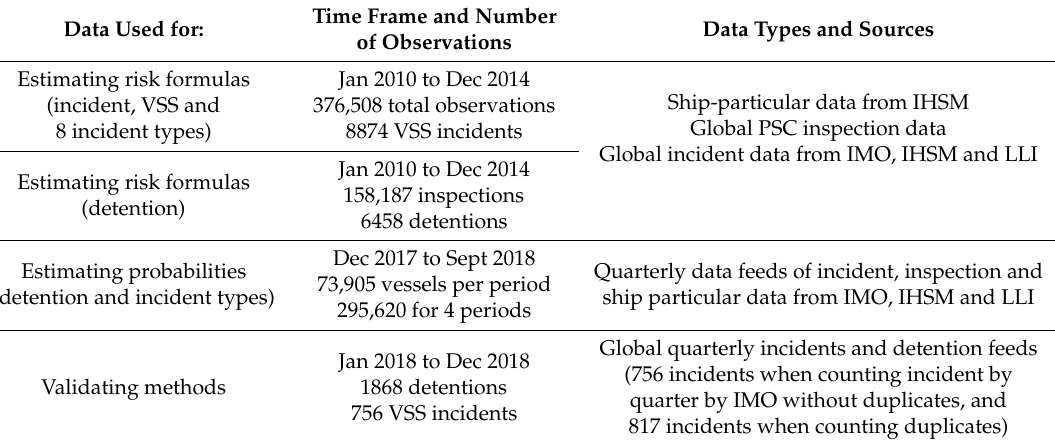
Table 1. Data sources used in the